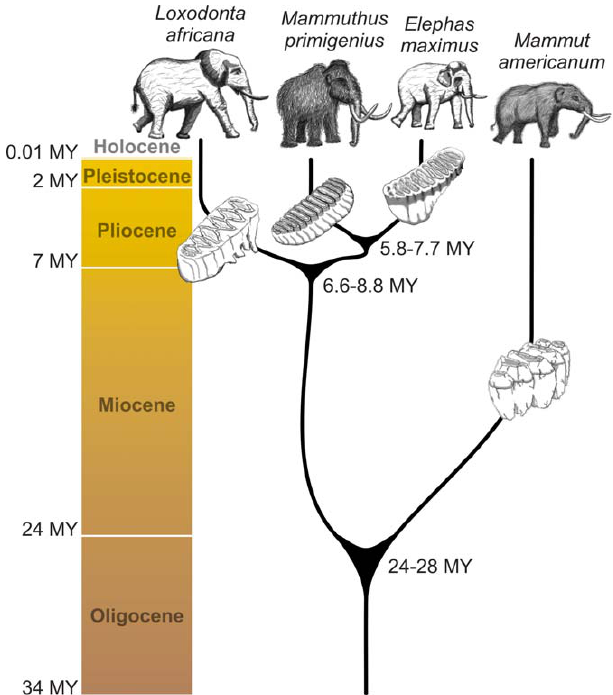
Figure 5. Phylogeny and Divergence Times Determined by This Study for the Four Proboscidean Species Analyzed